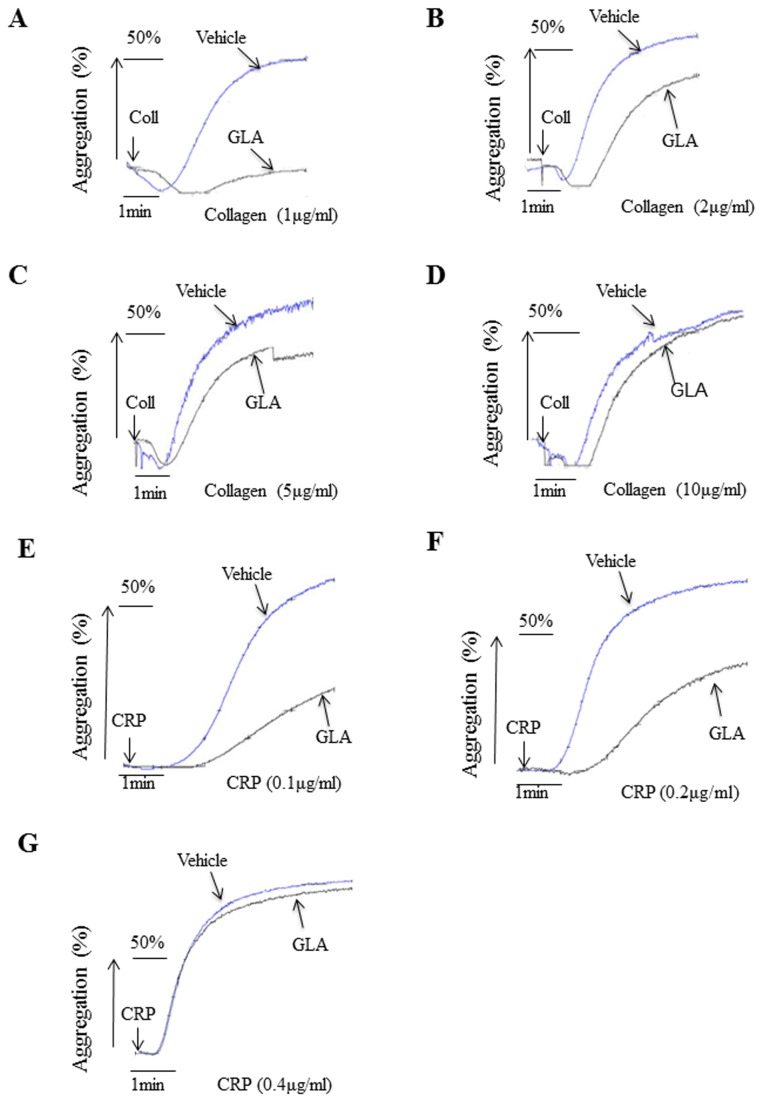
Effects of GLA on platelet aggregation induced by different concentration of collagen and CRP.Gel-filtered platelets (2.5×108/ml) were pre-incubated for 10 min with GLA (0.01μg / mL) or vehicle (DMSO). Platelet aggregation was initiated with 1μg/ml (A), 2μg/ml (B), 5μg/ml (C), and 10μg/ml (D) of collagen, and 0.1μg/ml (E), 0.2μg/ml (F), and 0.4μg/ml of CRP (G). The aggregation curves are the representatives of at least three individual experiments.